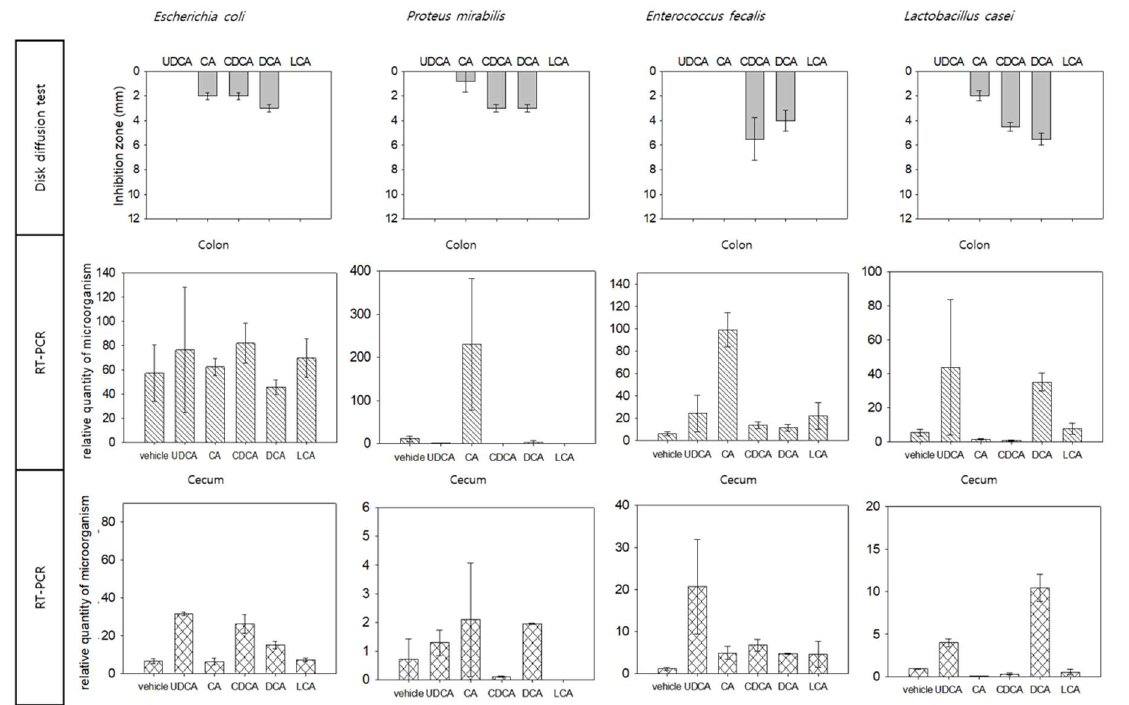
Figure 4. Comparative analysis of in vitro and in vivo results. Direct inhibition of bile acids against specific selected strains (in vitro) and the effect on mice large intestine strains (in vivo) were compared. For in vitro experiments, disc diffusion was used, and quantitative analysis (RT-PCR) of strains in the large intestine was performed separately in the colon and cecum.